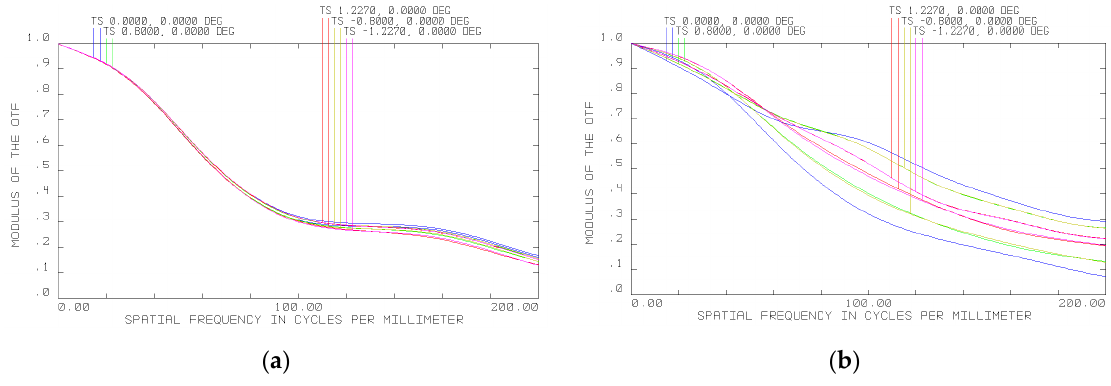
Figure 7. MTF of hyperspectrometer following spectral unit adjustment relative to photosensitive array at ( a ) − 40 ◦ C and ( b ) 45 ◦